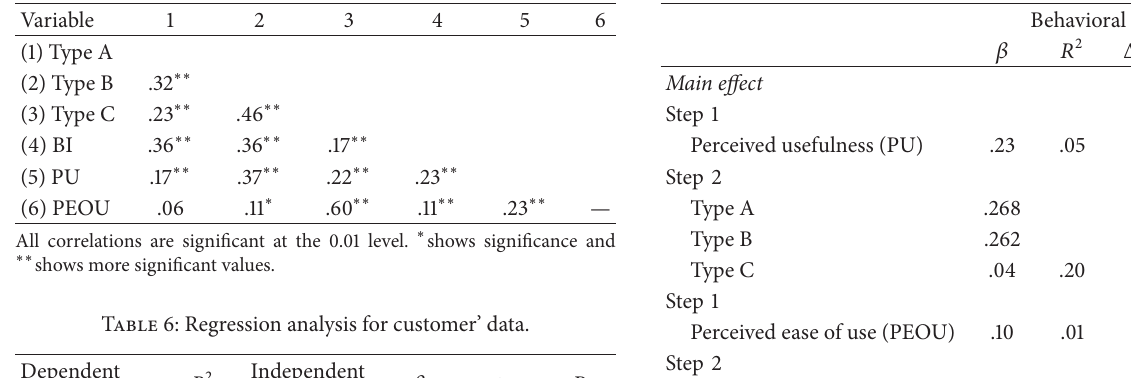
Table 5: Customers’ correlation among variables.